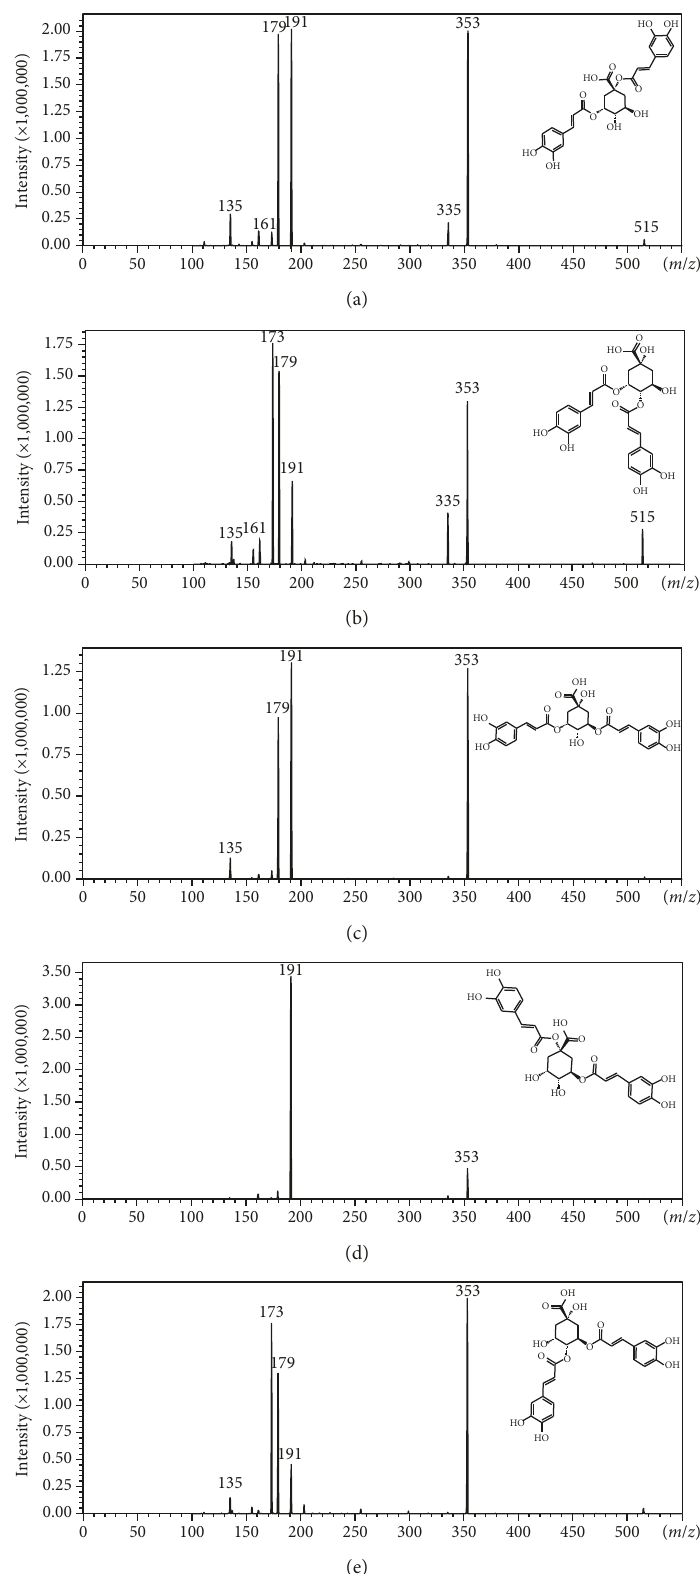
Figure 2: Product ion scan (PIS) spectra and fragmentation pathways of (a) 1,3-diCQA, (b) 3,4-diCQA, (c) 3,5-diCQA, (d) 1,5-diCQA, and (e) 4,5-diCQA authentic